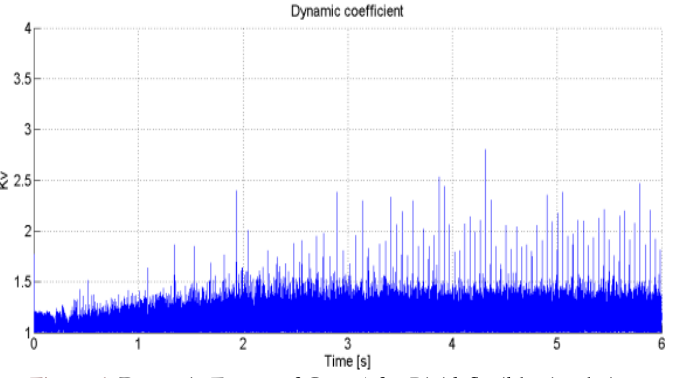
Figure 6: Dynamic Factor of Gear 4 for Rigid-flexible simulation